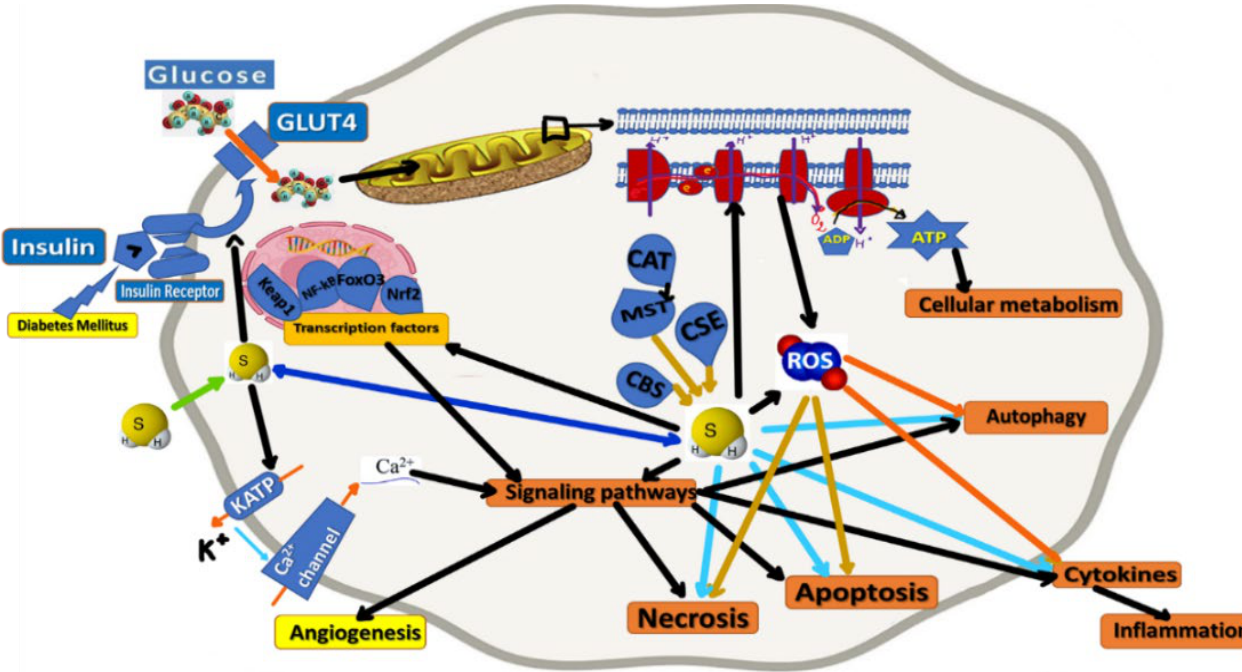
Figure 2. Intimate mechanisms as molecular therapeutic/rehabilitative targets of H 2 S in the case of cells influenced by DM (which impacts glucose uptake, affecting the relation of insulin signal transmission pathway with the cell glucose uptake). Intimate connections are indicated through black arrows, while increasing influences are marked by green arrows and inhibiting or reducing impacts of H2S through blue arrows. Finally, the biosynthesis pathways are stated, represented by cystathionin- β -synthase (CBS), cystathionin- γ -lyase (CSE), and 3-mercaptopyruvate sulfurtransferase (MST), the latter connected with cysteine aminotransferase (CAT).